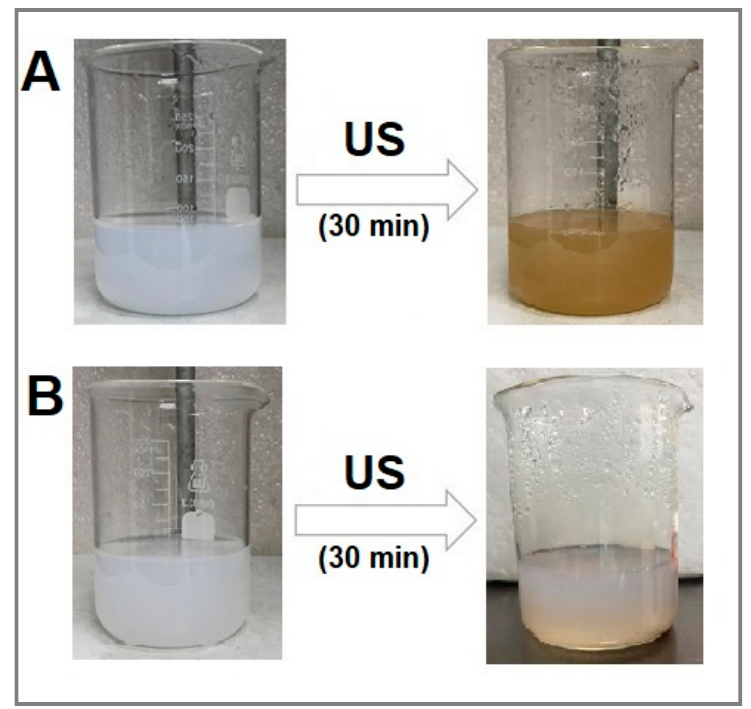
Figure 1. Pathway for the synthesis of silver selenide nanoparticles (NPs). ( A ) Sample made of 3.4 mM [Ag + ] f and 1.7 mM [Se 4+ ] f in the presence of 40 mg mL − 1 of fructose and 10 mg mL − 1 of starch exposed to ultrasound (US) irradiation for 30 min (59-s pulse ON, 5-s pulse OFF). ( B ) Control sample made of 3.4 mM [Ag + ] f and 1.7 mM [Se 4+ ] f exposed to US irradiation under the same conditions as in (A).